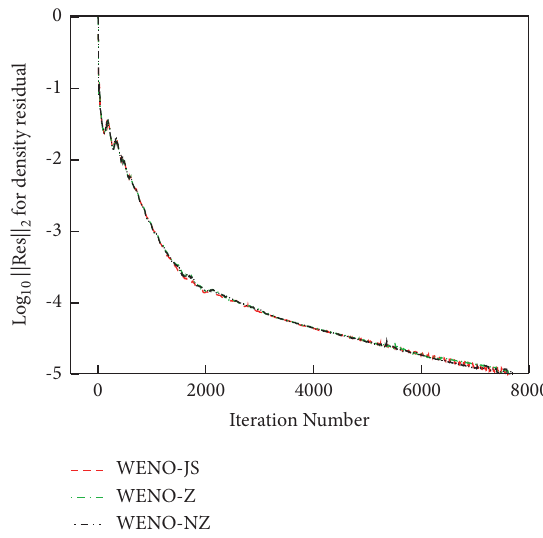
Figure 7: Convergence history for the RAE2822 airfoil.